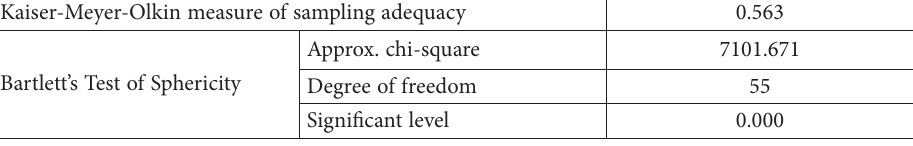
Table 2. KMO and Bartlett tests